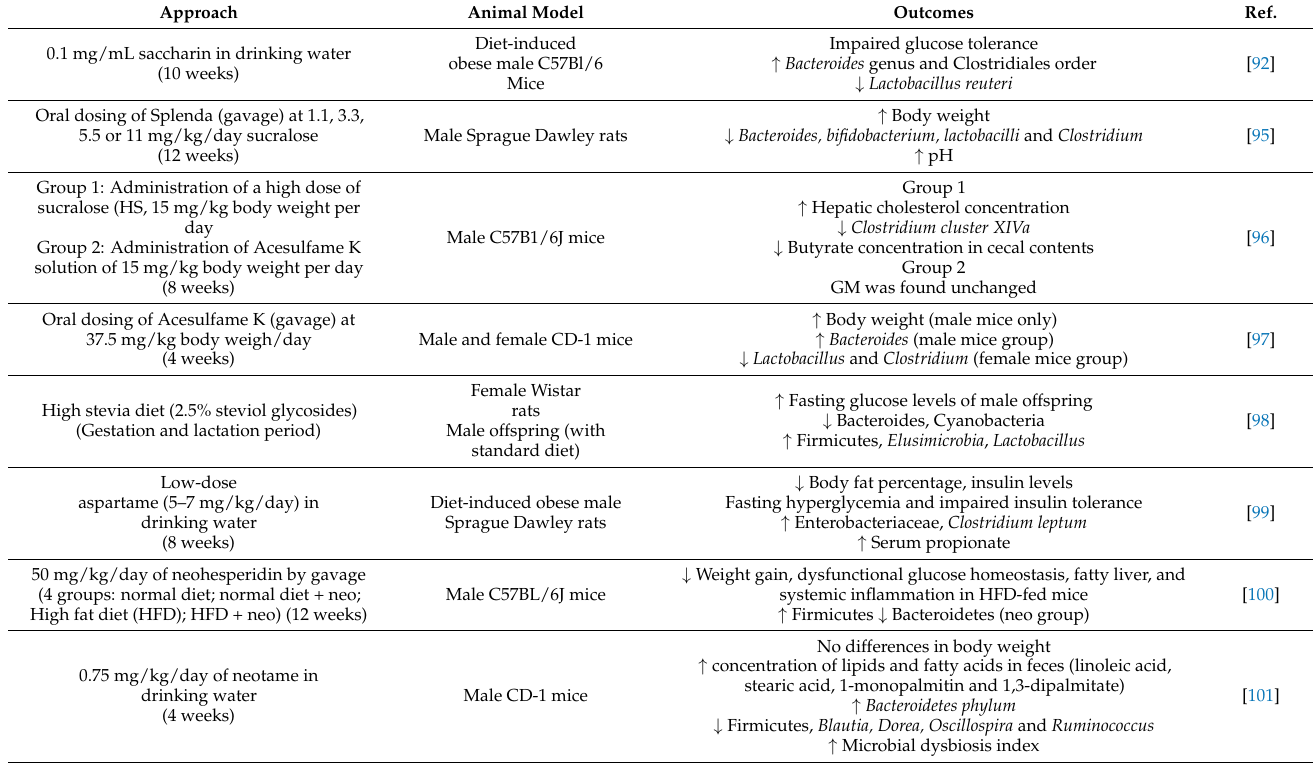
Table 2. Effects of non-nutritive sweeteners on gut microbiota and metabolic health. Approach Animal